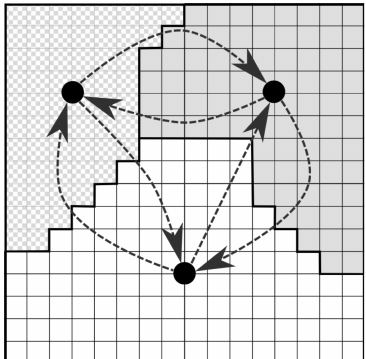
Figure 2. Example grid divided up into 3 connected regions or nodes. The agent’s motion model consists of different regions (also referred to as nodes). Each region contains a subset of cells (white, grey or checkered). A cell may belong to multiple regions, not shown. Each region has a central point (black circle) contained within the cell. The actions available to the agent at a given region is to either search the current region, or move to an adjacent region along a path connecting central